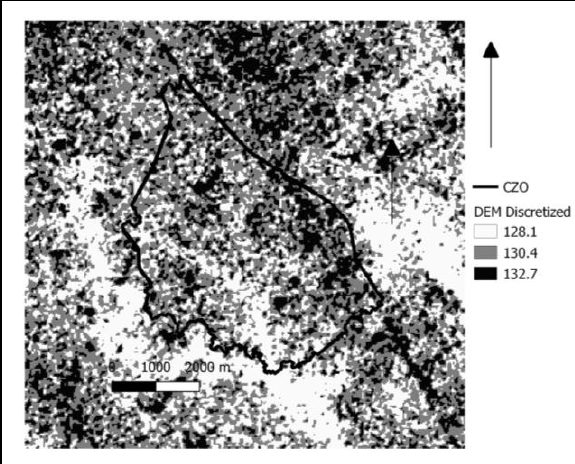
Figure 4. Discretized DEM for threshold = 0.0001